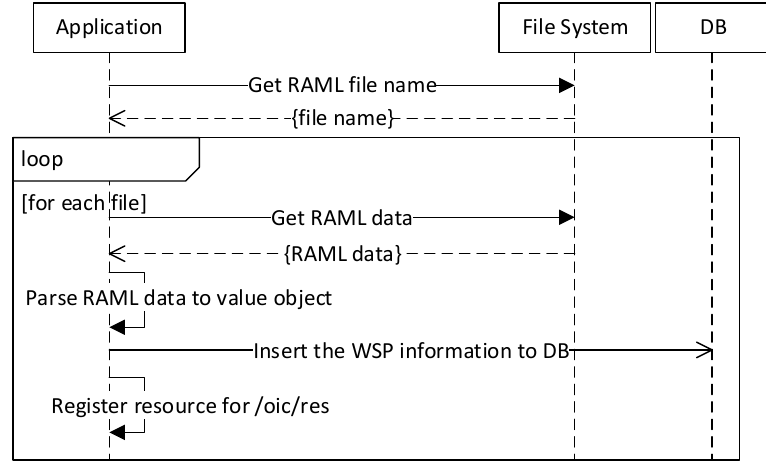
Figure 7. WSP information registration.